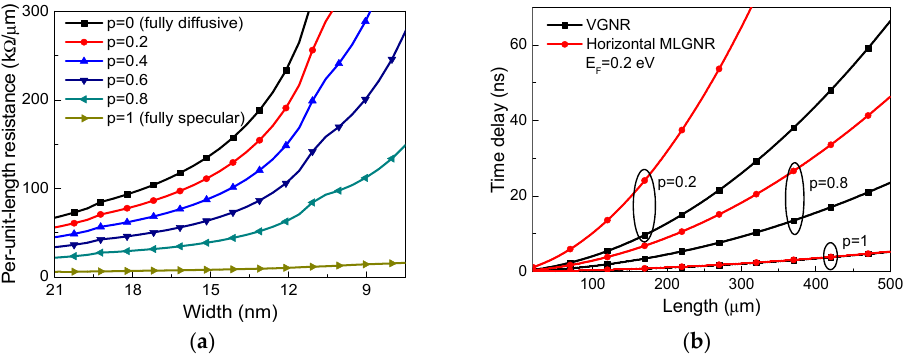
Figure 7. ( a ) Per-unit-length resistance of the monolayer GNR with different specularity parameters. ( b ) Propagation delay of intermediate level Cu, horizontal MLGNR, and VGNR interconnects at the 7.5 nm technology node [44].